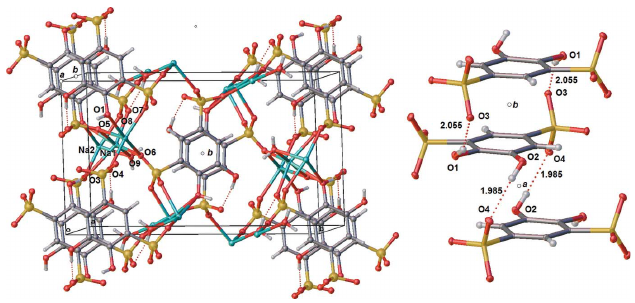
Figure 7 Packed structures of Na 2 (tiron) (cid:2) H 2 O. Left: packing arrangement in the unit cell. Right: displacement ellipsoid plot showing alternating units in a (cid:3) -stacked arrangement in the crystallographic a- axis direction. Ellipsoids are shown at the 50% probability level, hydrogen atoms are shown as spheres.